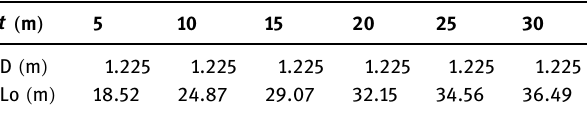
Table 9: Pipe thickness vs optimum diameter and safe span length